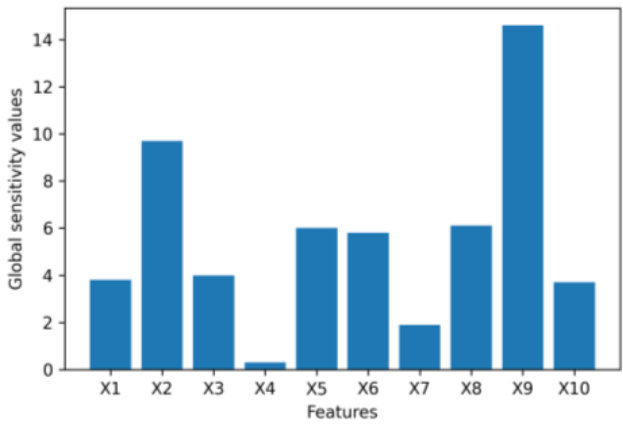
Figure 10. Global feature importance values for dataset 1.